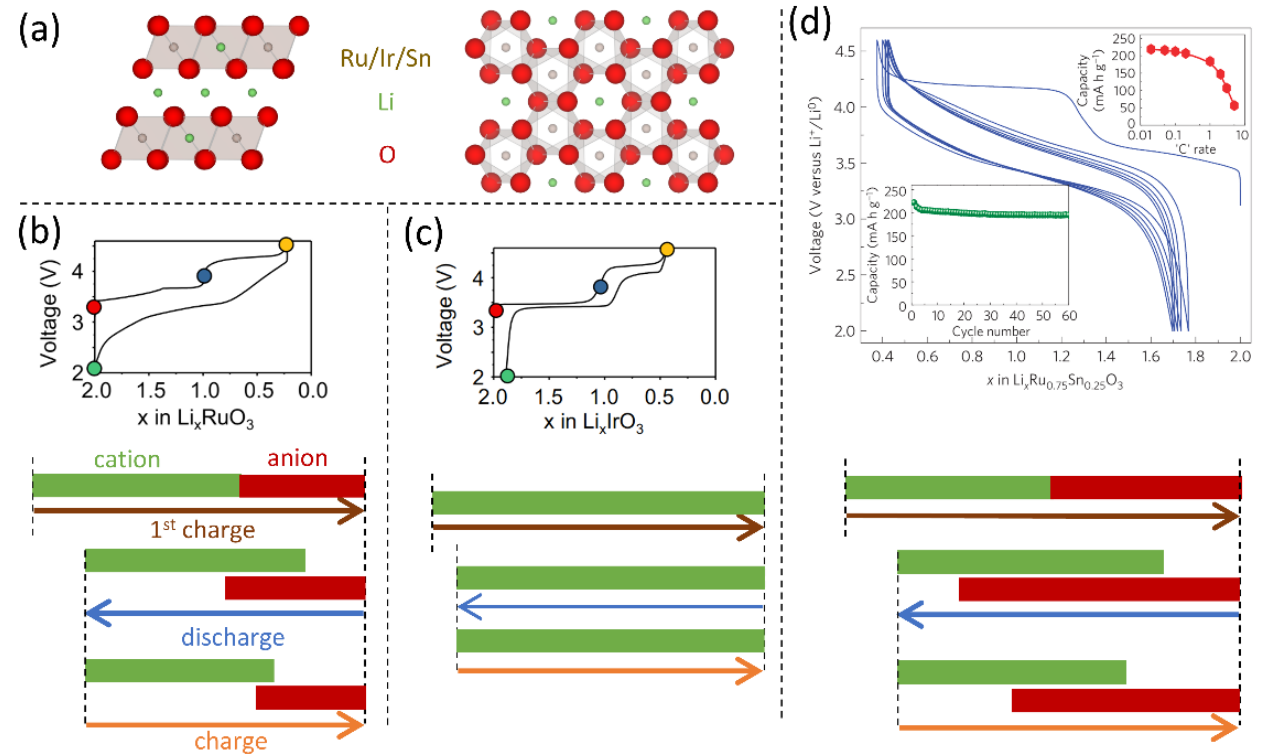
Figure 7. ( a ) The crystal structures of Li 2 RuO 3 , Li 2 IrO 3 , and Li 2 SnO 3 . The charge-discharge curves and redox evolution of ( b ) Li 2 RuO 3 , ( c ) Li 2 IrO 3 , and ( d ) Li 2 Ru 0.75 Sn 0.25 O 3 . Reproduced with permis-